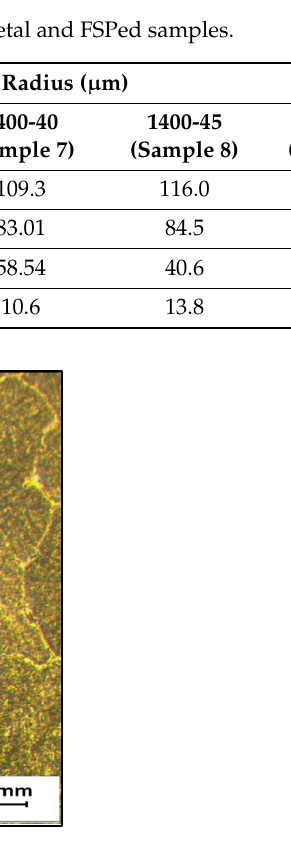
7 of 17 Figure 7. Microstructure of stir zone (SZ), thermo-mechanical affected zone (TMAZ), and heat-af- fected zone (HAZ) boundary (5×) of FSPed Sample 2. The grain size of some of the FSPed samples was also measured and presented in Table 3. The outermost part of the sample (BM) that is not stirred by the FSP tool has the largest grain size and the grain size is similar to the unprocessed recycled AA 6063. Closer to the stir zone, the grain size was reduced, and the smallest grain size was observed at the stir zone. Figure 8 demonstrates grain size measurement using the metallurgical mi- croscope software, VIS Pro, China. The maximum reduction in grain size is about 96% and the smallest average grain size was reduced to 4.6 μ m. Besides, it also shows that the BM part of each sample is also similar, and their grain sizes all exceeded 100 μ m. In addition, the microstructure also shows that the grain size becomes smaller when getting closer to